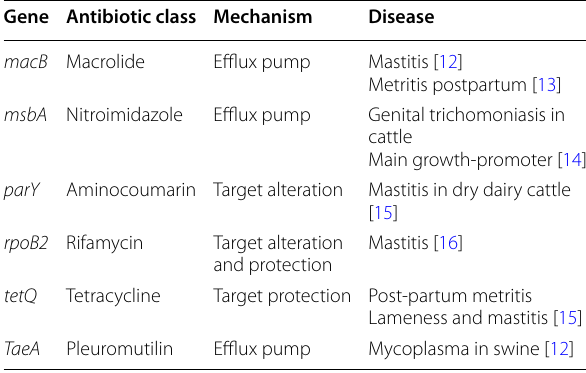
Table 1 The 6 most prevalent antimicrobial resistance genes found in rumen and the characteristic of the antimicrobials to which they confer